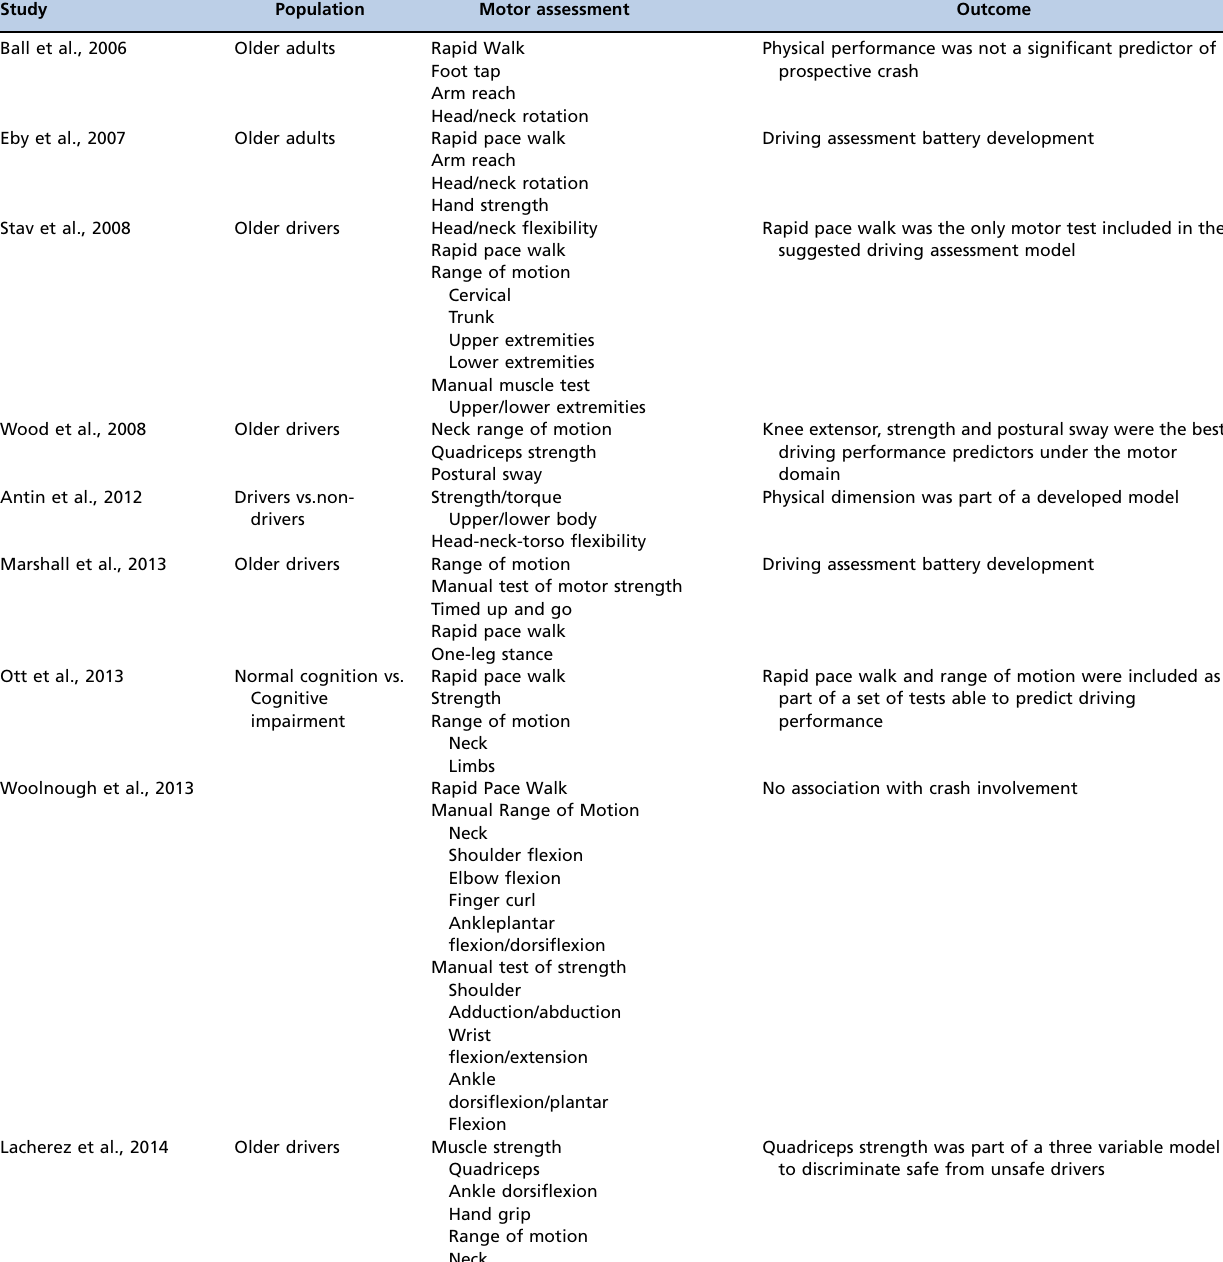
Table 1 - Motor evaluations in the proposed driving assessment